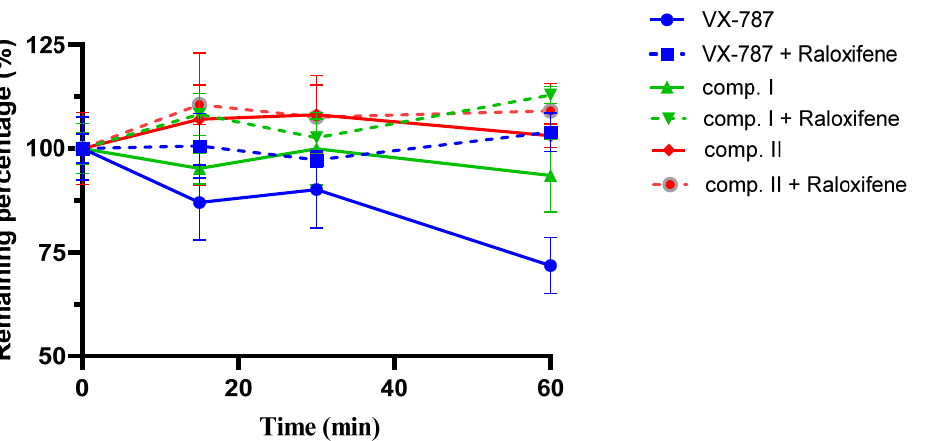
Figure 6. Residual percentage of VX-787 and comp. I / II in 0.5 mg/mL human liver cytoplasm. Error bars are represented as mean ± SD, n = 3.